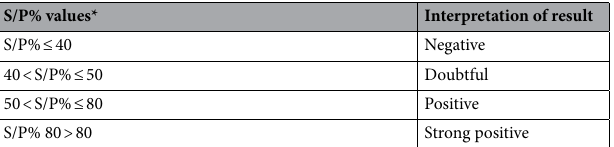
Table 1. Result interpretation of ELISA for Q fever. *The sample (S) to positive (P) was estimated using the following formula: S/P = ((OD Sample − OD NC )/(OD PC − OD NC ) ×